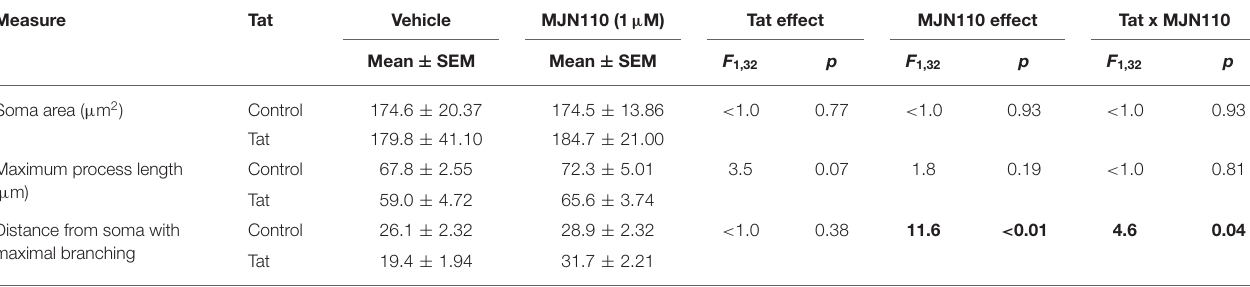
TABLE 1 | Effects of Tat (100 nM) and MJN110 (1 µ M) on neuronal morphology from frontal cortex neuron cultures a . Measure